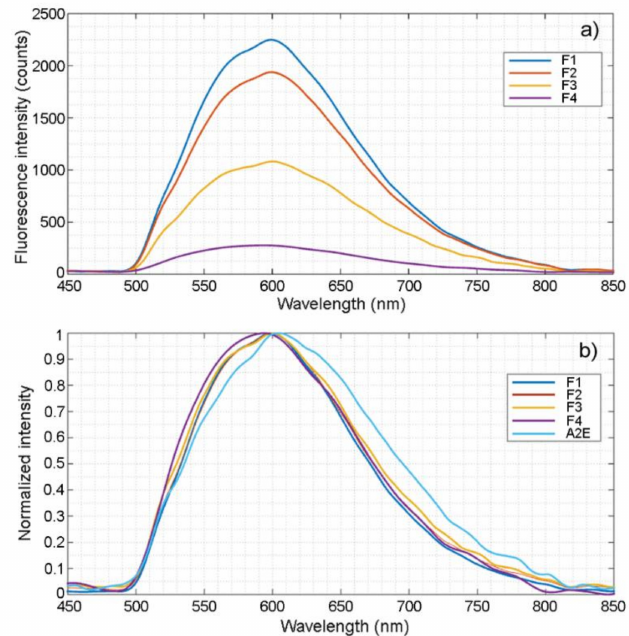
Figure 6. Autofluorescence emission by RPE granules. The emission spectrum of granules in each fraction (F1–F4) was in the range of 500 to 800 nm, peaked at 600 nm ( a ). Normalized spectral curves show that the curves are identical ( b ). The emission spectra from RPE granules are similar to that of synthetic A2E in H 2 O ( b